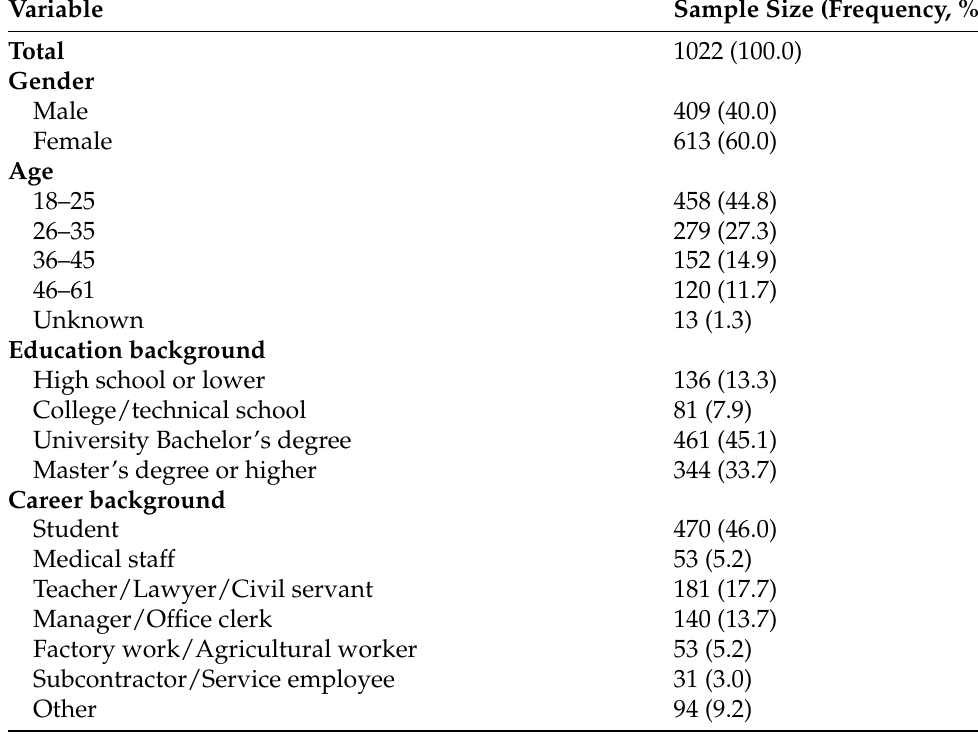
Table 1. Demographics of